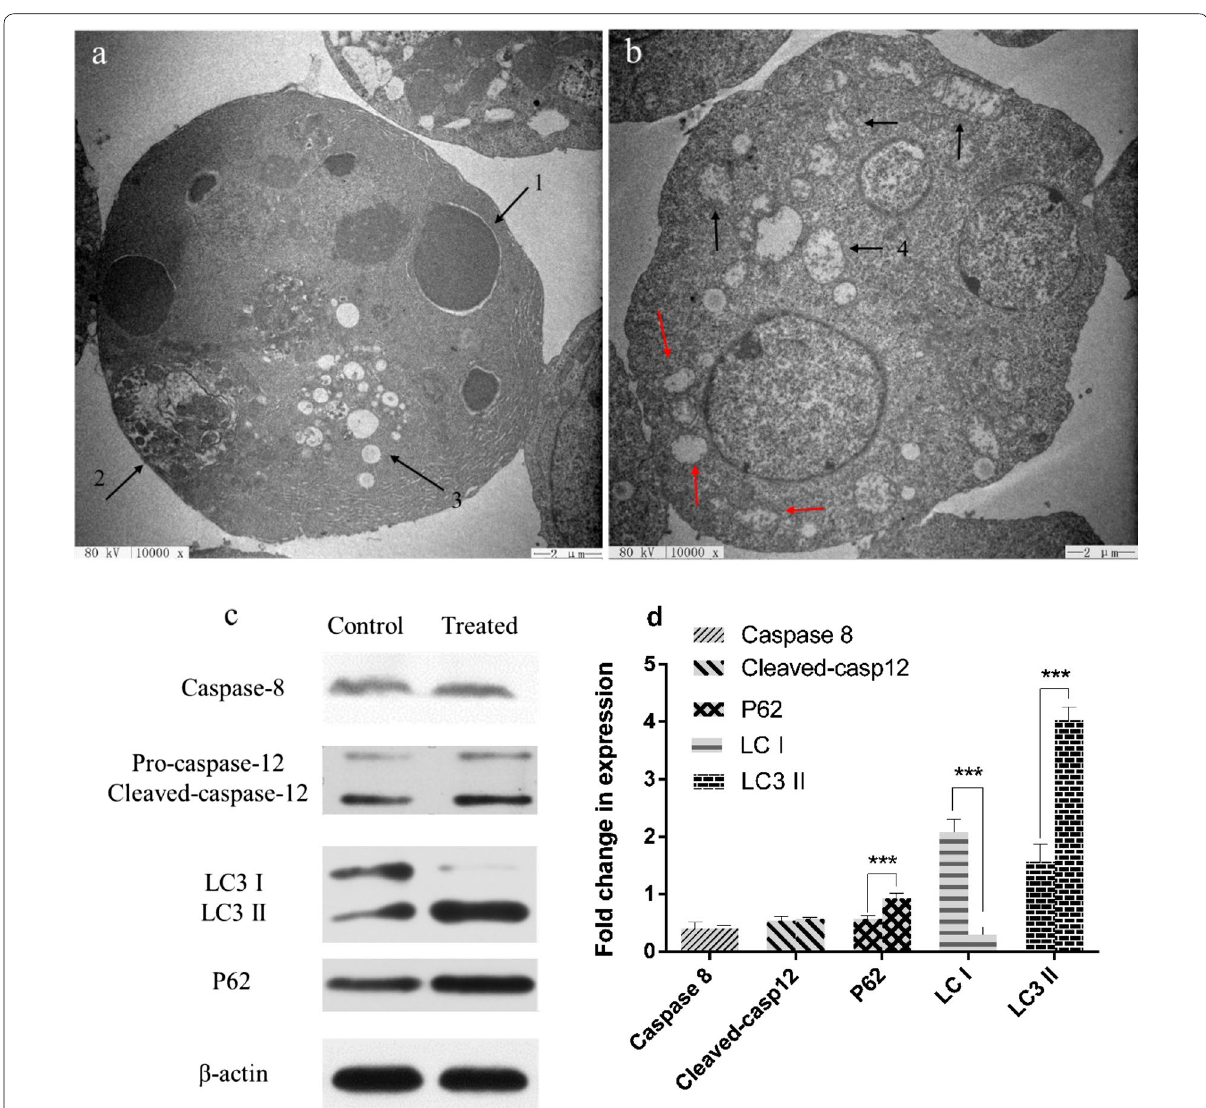
Fig. 9 TEM photo of lipopeptide-treated K562 cells and the western blot analysis of the expression of apoptosis-related proteins. a TEM photo of lipopeptide-treated K562 cells. Arrow 1 shows the apoptotic body; arrow 2 indicates the autophagosome; and arrow 3 indicates the cytoplasmic vacuoles, typical markers of paraptosis. The scale bar is 2 μm. b TEM photo of K562 cells treated with lipopeptides together with caspase inhibitors. The black arrows mark the mitochondrion swelling, and the red arrows mark the ER swelling; the scale bar is 2 μm. c The expression of key proteins related to autophagy and paraptosis. d Quantitative analysis of the levels of gene expression shown in